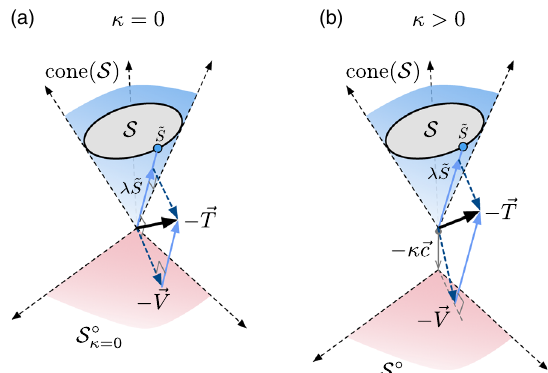
˜ ⃗ T ⃗ V S at (a) zero FIG. 3. Conic decomposition of − ¼ − þ λ margin κ ¼ 0 and (b) nonzero margin κ > 0 . Given a random ⃗ T ⃗ V ⃗ V − ⃗ T Gaussian , is found such that k k is minimized, while λ ˜ S is in cone ð S Þ and ˜ S is the anchor − ⃗ V is on the polar cone S ∘ κ : point, a projection on the convex hull of S